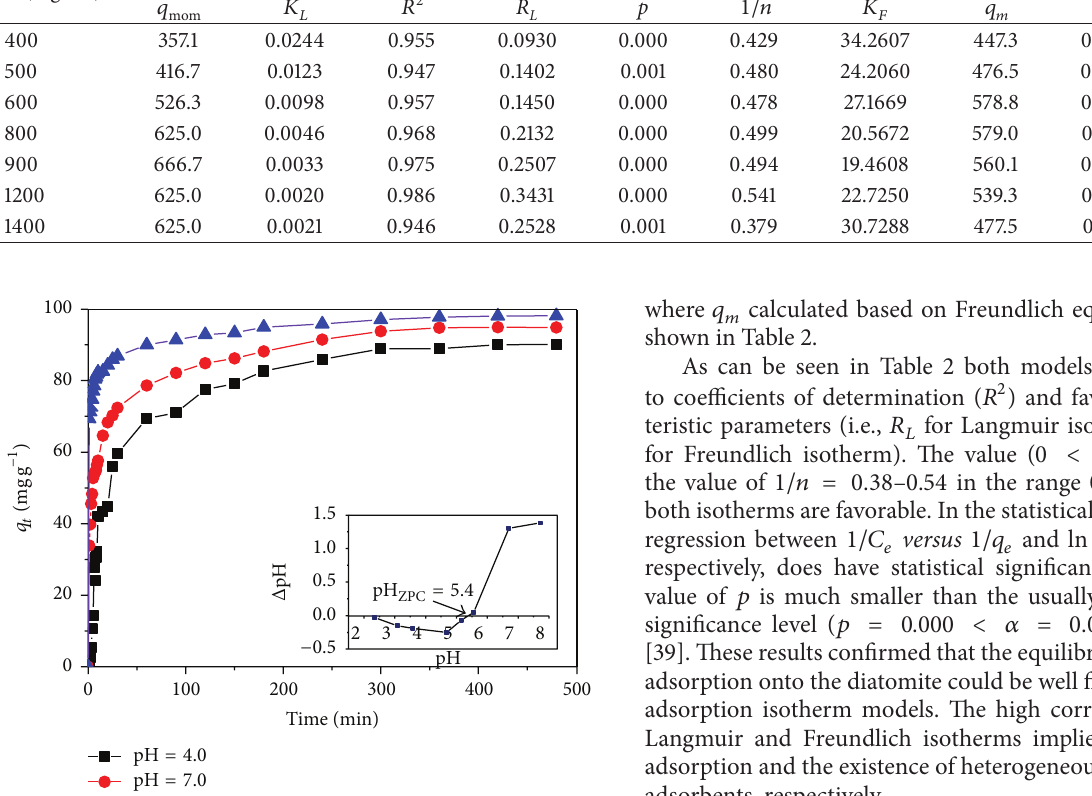
Table 2: The isotherm parameters of Langmuir and Freundlich models at various concentrations from 400 to 1400 mgL −1 . 𝐶 (mgL −1 ) Langmuir model